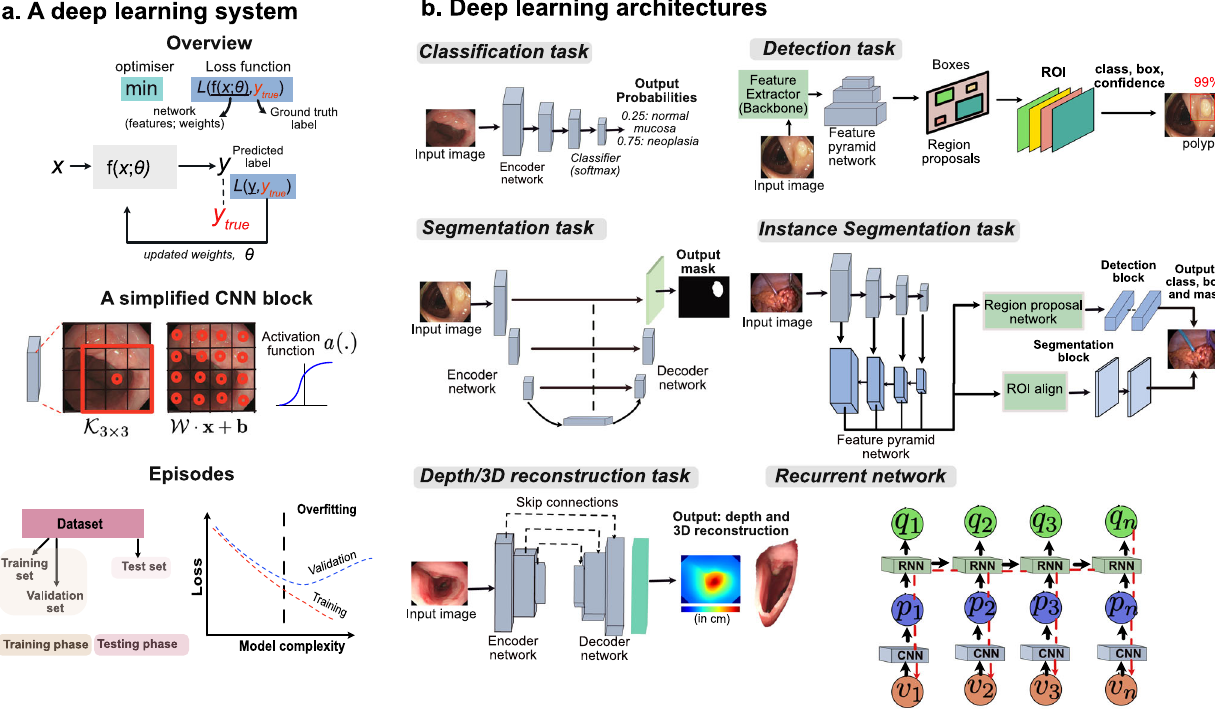
Fig. 3 Deep learning system and its widely used designs. a A conceptual representation of a deep learning system with an optimiser for minimising a loss function. A simpli fi ed convolutional neural network (CNN) block comprising a 3 × 3 kernel and computed weight for each pixel with kernel weights and bias is provided. It also demonstrates a non-linear activation function applied to capture more complex features. The training and test phase consists of split datasets where the validation set is used to guarantee that the learnt parameters generalise and do not over fi t the training dataset. A model over- fi tting graph is shown that is regulated using a validation set. b Some widely used deep learning architectures are shown for various tasks in endoscopic image analysis. For the classi fi cation network, only an encoder network is used that is usually followed by a classi fi er such as softmax 3 . For detection, features are extracted using an encoder network, which is then pulled using a region proposal network to predict both the class and the bounding box representations 128 . For semantic segmentation, the encoder features are up-scaled to image size per-pixel classi fi cation. Similarly, for the instance-segmentation task, both the region proposals for bounding boxes and per-pixel predictions for masks are used 131 . The idea of a depth estimation network is to understand how far the camera is from an anatomical region providing distances in the real-world coordinate system 22 . Finally, recurrent neural networks ( aka RNNs) can embed temporal video information to re fi ne current predictions from a CNN network 64 . Here the sequential frame inputs v 1 ,.., v n are fed to the CNN network producing visual feature vectors p 1 ,..., p n , which are then fed to the RNN network. The RNNs output represents the temporal relationship providing context-aware predictions for each frame such that the output for the n th frame q n is dependent on both current